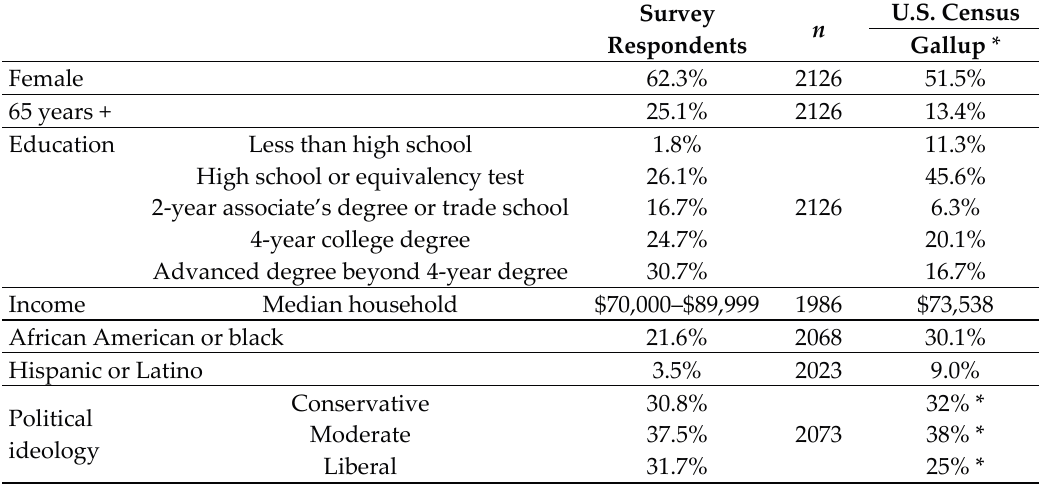
Table 1. Demographics of survey respondents compared with Maryland